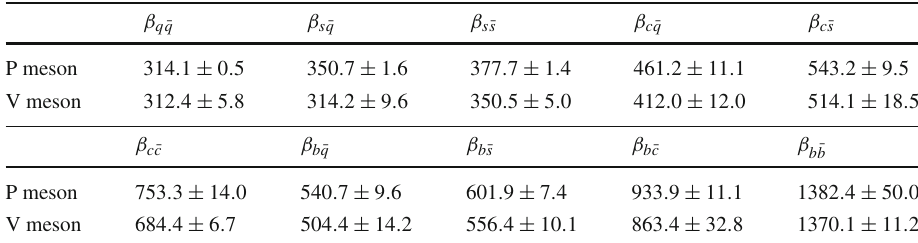
Table 5 The values of Gaussian parameters β (in unit of MeV), where q = u and